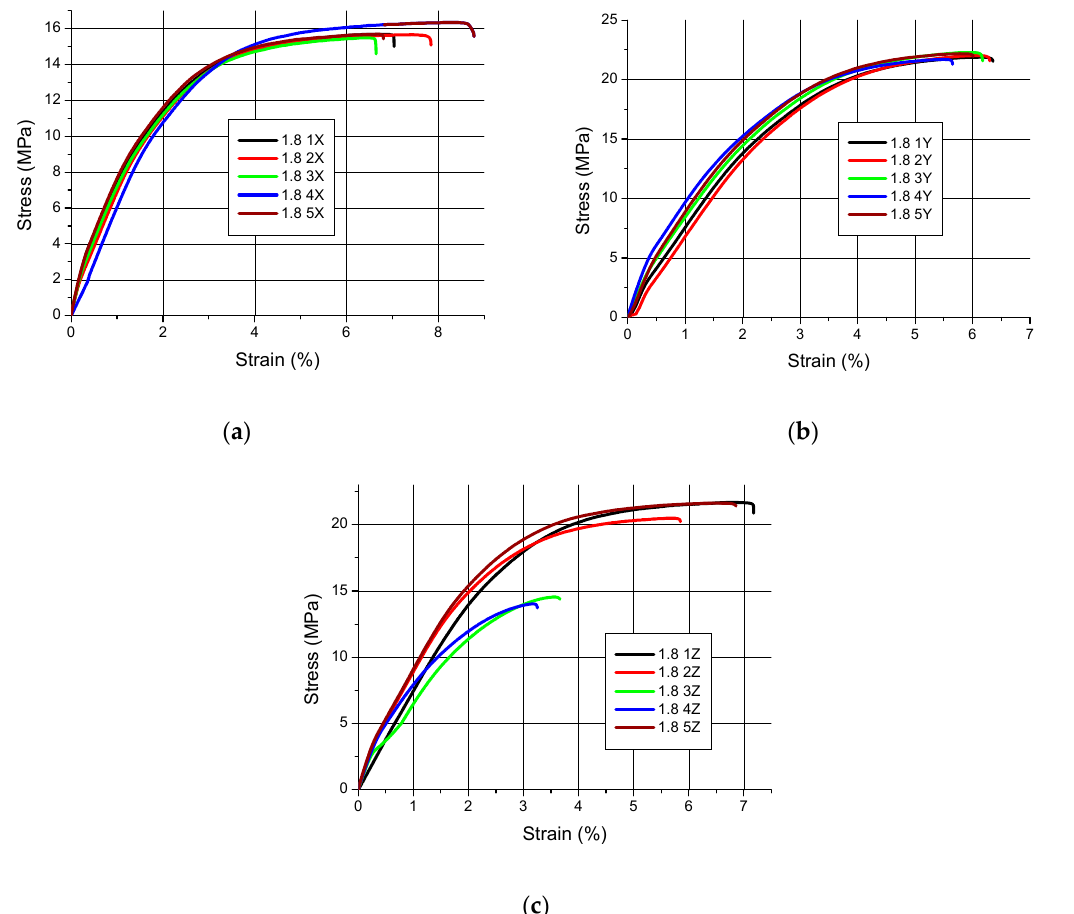
Figure 2. Tensile curves for samples with a nominal thickness of 1.8 mm ( a ) orientation X, ( b ) orientation Y, ( c ) orientation Z.